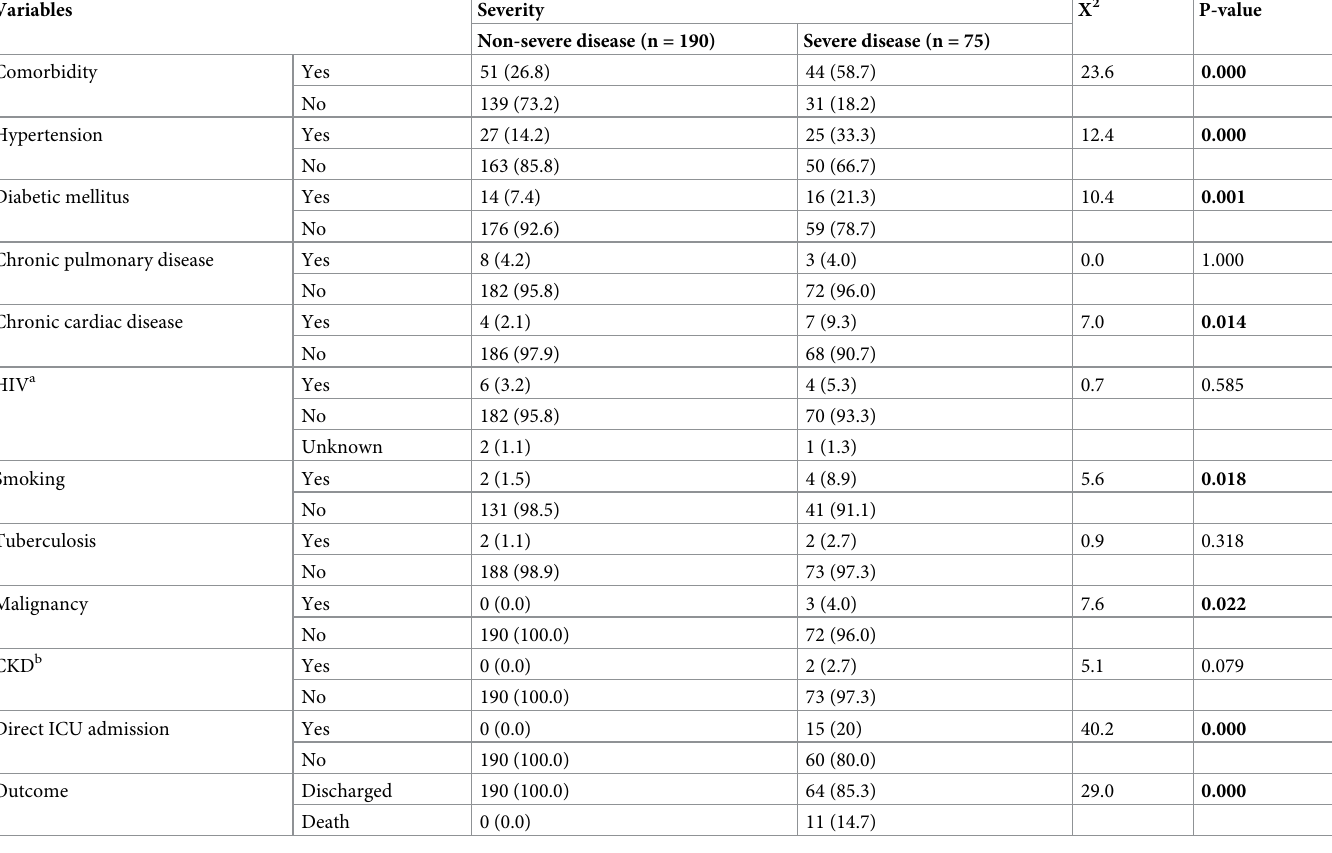
Table 3. Distribution of comorbidities, disease severity, and outcome of study